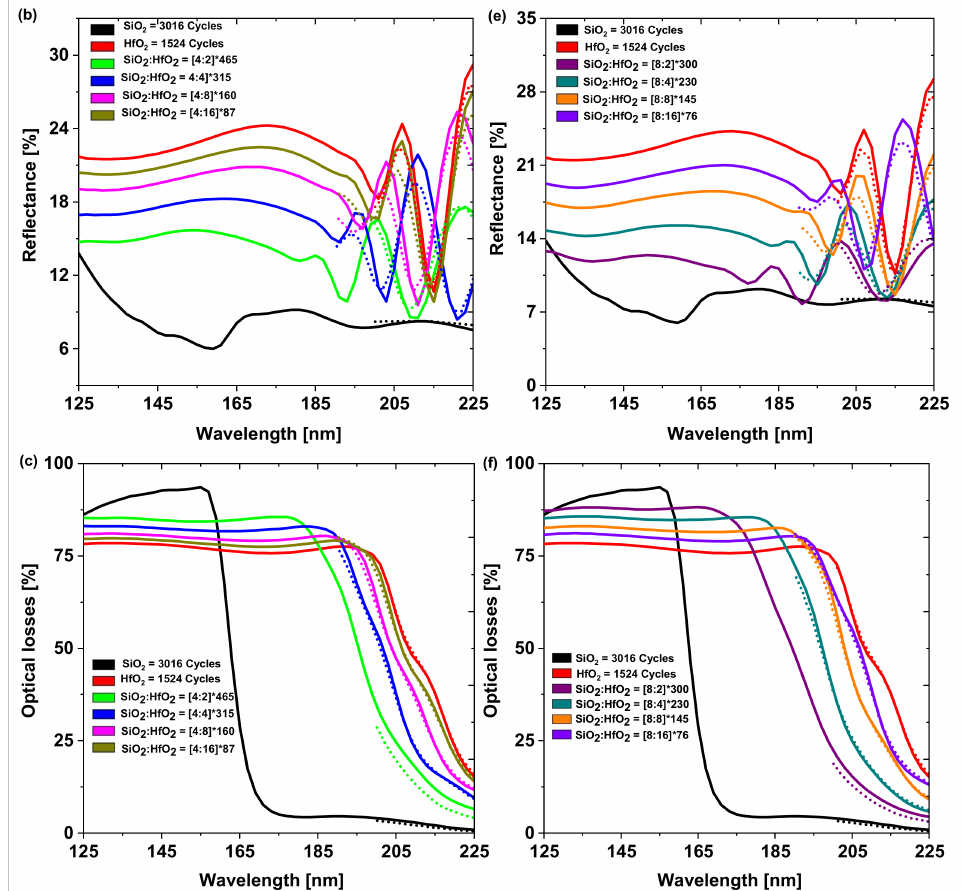
Figure 7. Transmittance T , reflectance R , and optical losses spectra of SiO 2 :HfO 2 heterostructures with ( a – c ) 4 and ( d – f ) 8 cycles of SiO 2 in the vacuum ultraviolet spectral ranges (dotted curves UV–vis, solid curves VUV